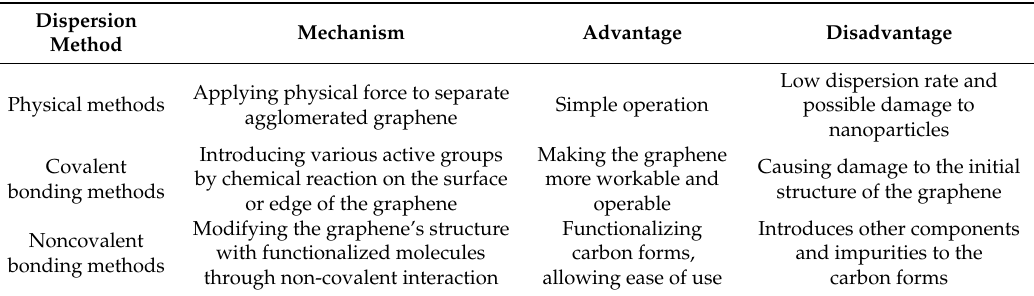
Table 7. A table presenting the advantages and disadvantages of methods of dispersing carbon-based materials, adapted from Liang et al. under open access © School of Materials Science and Engineering, Southwest Jiaotong University, Chengdu 610031, China [112].